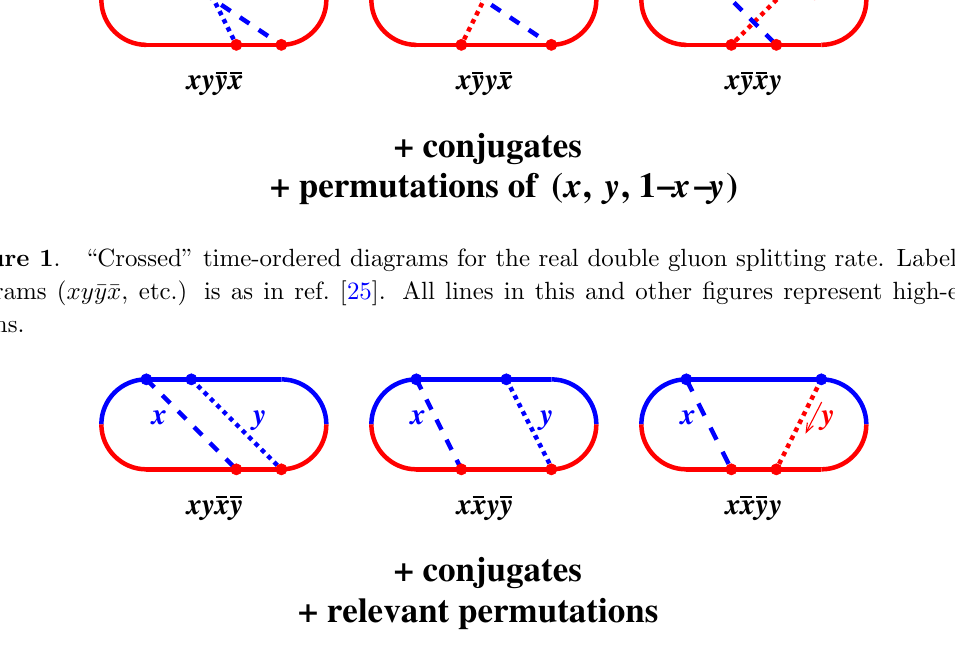
Figure 2 . \Sequential" time-ordered diagrams for the real double gluon splitting rate